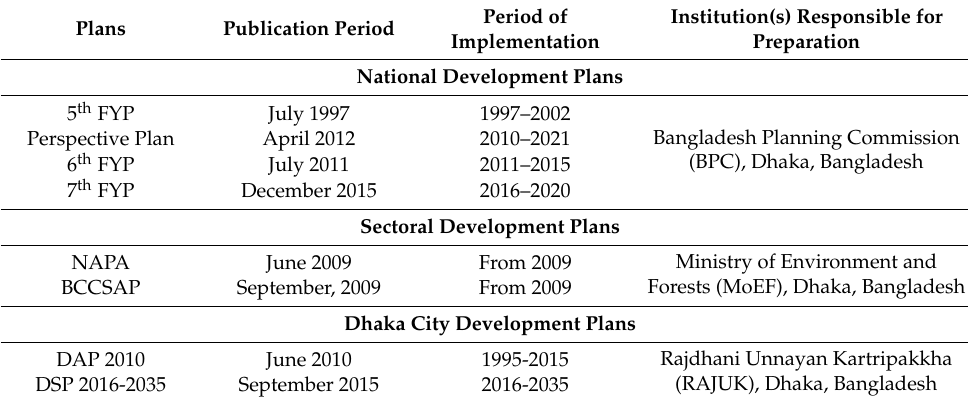
Table 1. The Preparation of selected National, Sectoral, and Dhaka City Development